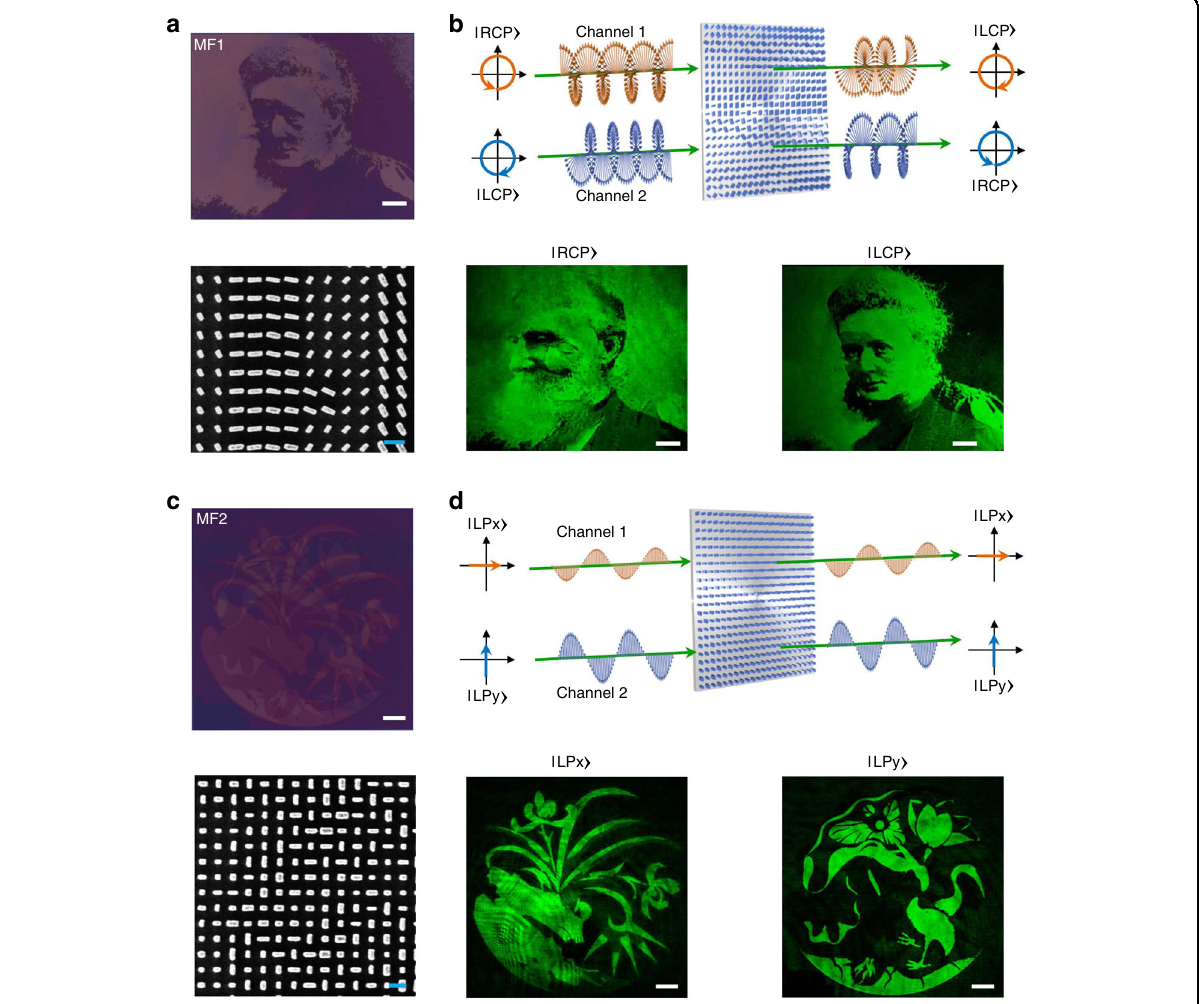
Fig. 3 Experimental demonstration of two channel metasurface nanoprinting enabled by amplitude control of orthogonal polarization states. a Top: optical microscope image of the fabricated metasurface device MF1. Scale bar: 50 μ m. Bottom: scanning electron microscopy (SEM) image of MF1. Scale bar: 500 nm. b Top: schematic illustration of device MF1 for switchable nanoprinting, using two orthogonal circular polarization channels. Bottom: experimental results for chirality-dependent nanoprinting grayscale portraits. By switching RCP light to LCP light, Kelvin ’ s portrait and Madame Curie ’ s portrait can be obtained in the near fi eld, respectively. Scale bar: 50 μ m. c Top: optical microscope image of the